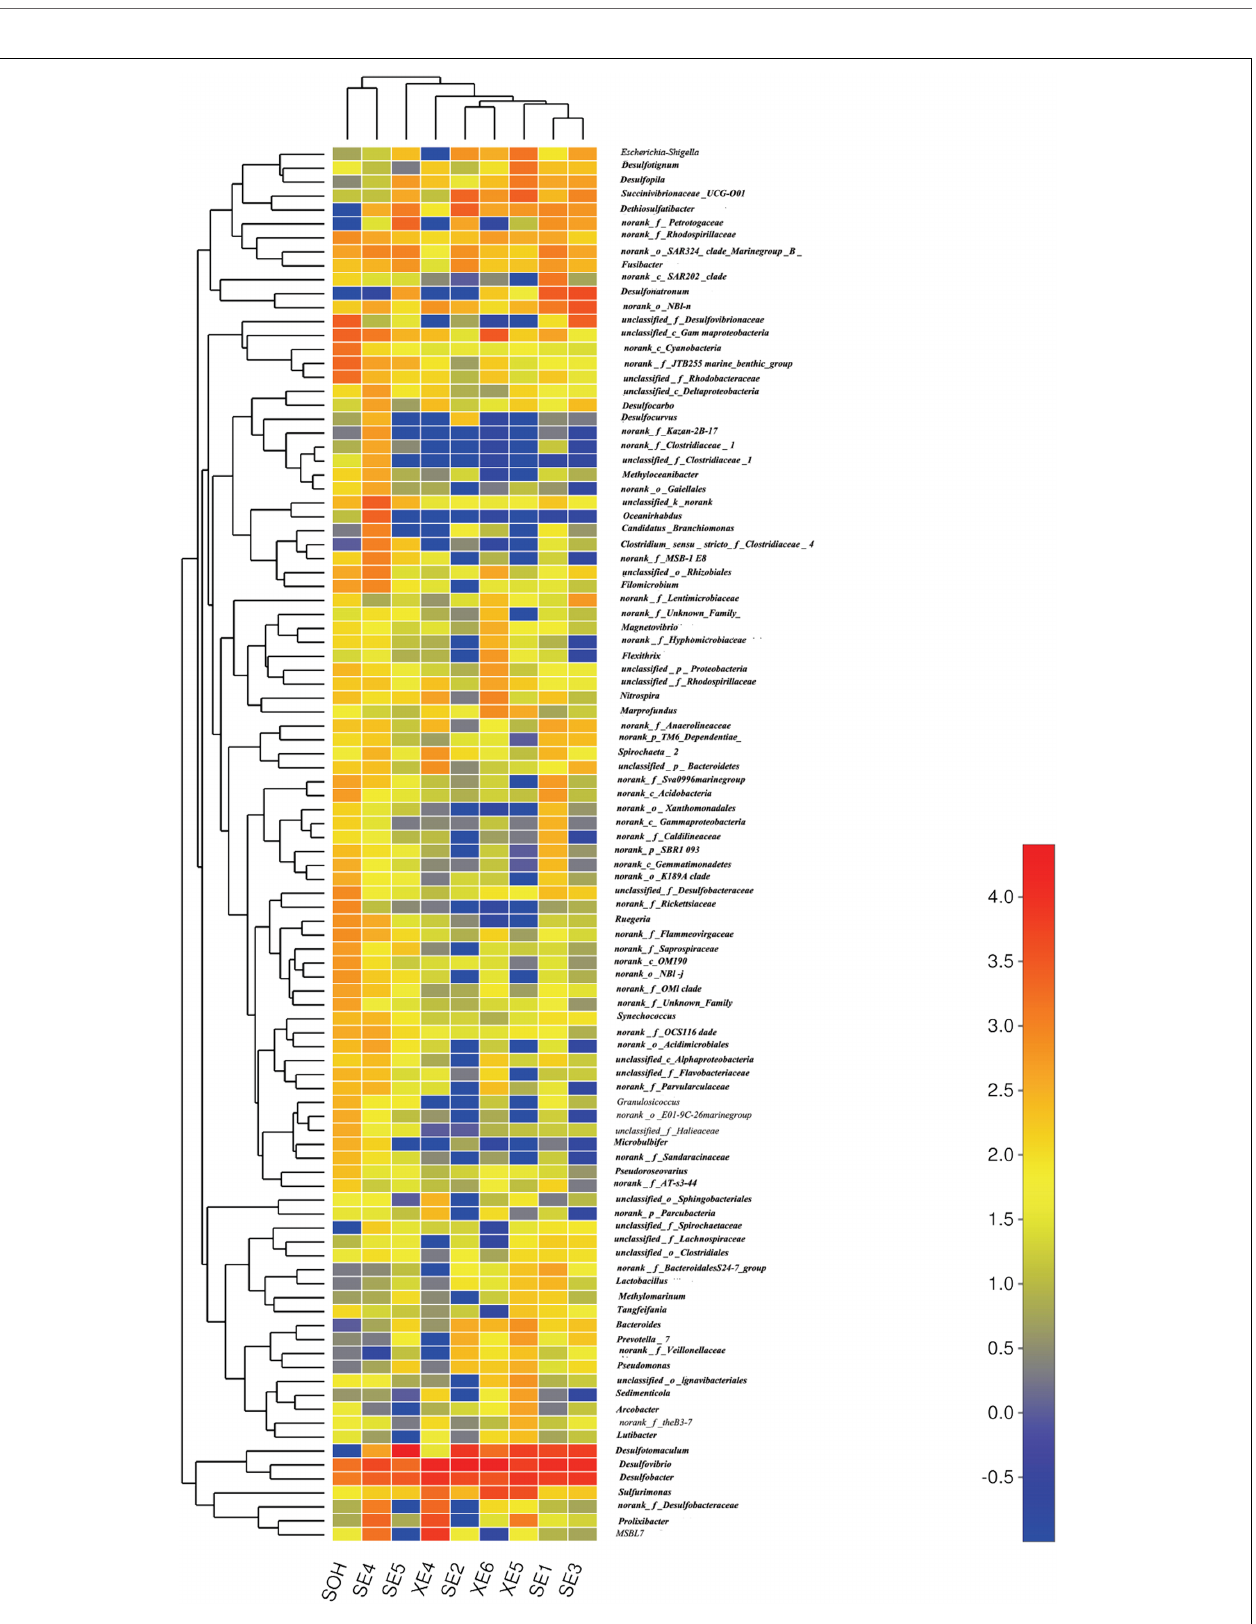
Frontiers in Microbiology |